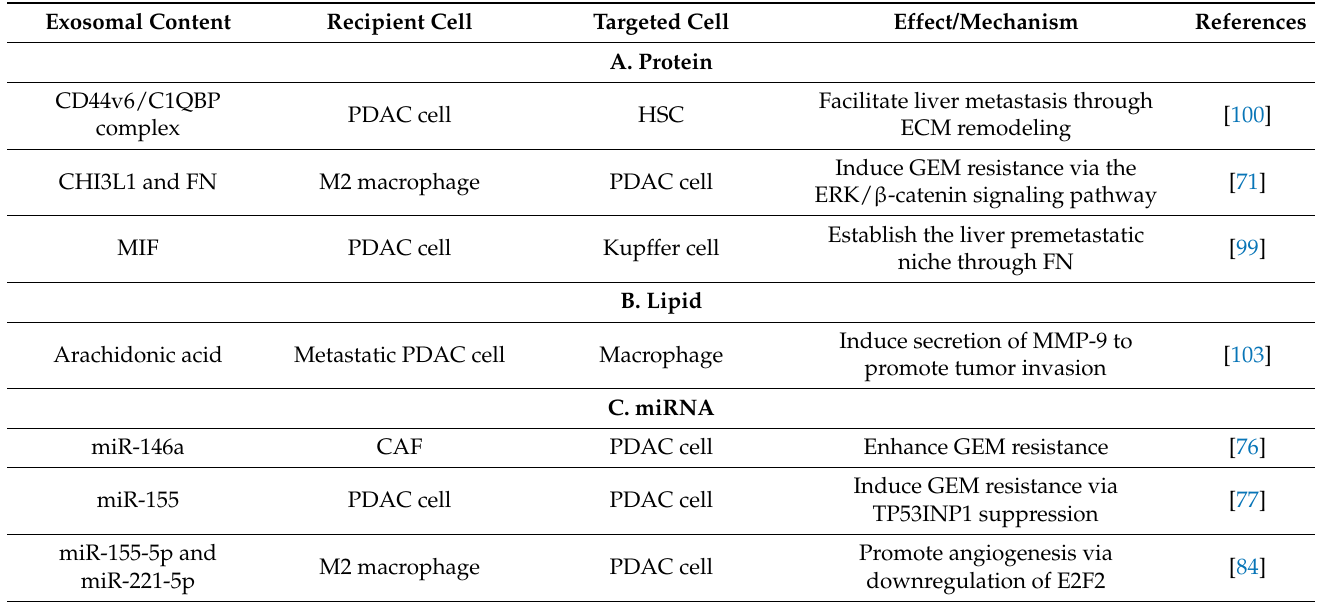
Table 1. Involvement of exosomal cargos in PDAC